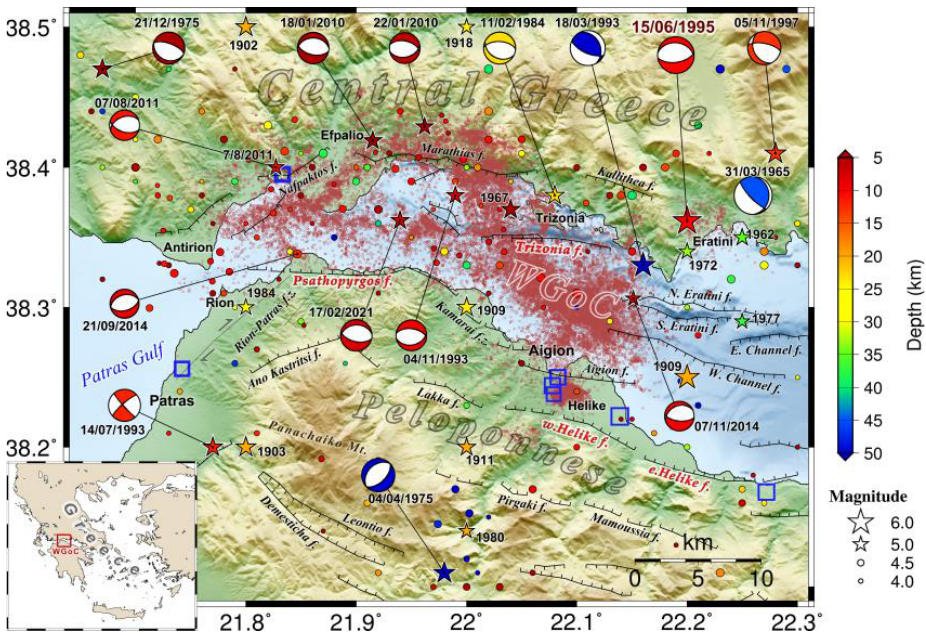
Figure 1. Seismotectonic map of the western Gulf of Corinth (WGoC). Solid circles and stars (for M w ≥ 5.0) denote earthquakes with M w ≥ 4.0 from the 1900 – 2009 catalogue of Makropoulos et al. [25], extended in this study up to 2019, with symbol size proportional to the magnitude (M w ) and color according to the focal depth. Selected microseismicity, presented with small, hollow, red cir- cles, is adopted from the 2000 – 2015 relocated catalogue of Duverger et al. [3]. Focal mechanisms of significant events, presented as beachballs, are adopted from [26 – 32], as well as the databases of the NKUA, NOA, CMT, and ISC. Blue squares mark the macroseismic epicenters of historical earth- quakes (1000 – 1899) acquired from the SHEEC database [33]. Fault lines are after [10,14,34,35]. Faults marked with red labels were used for the stochastic seismic hazard modeling in this study.